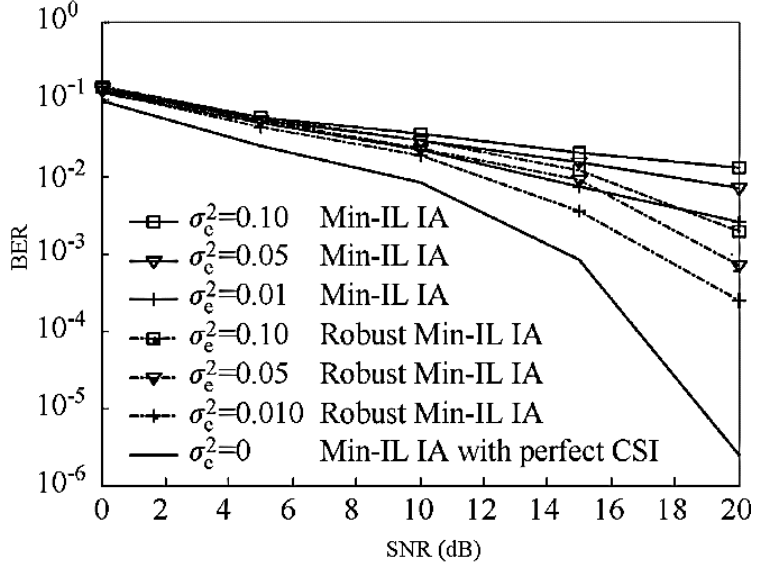
Figure 7. BER comparison under time delay error CSI for multiple cells and users.